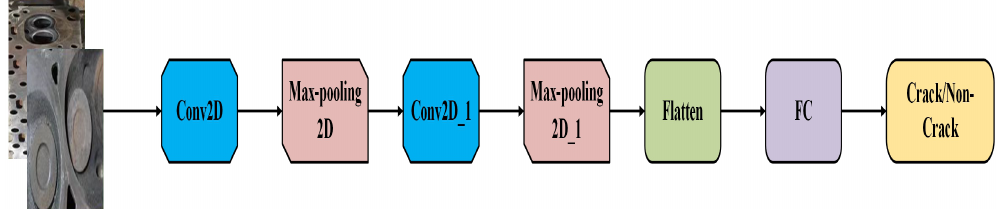
Figure 2. Framework of the LAECNet